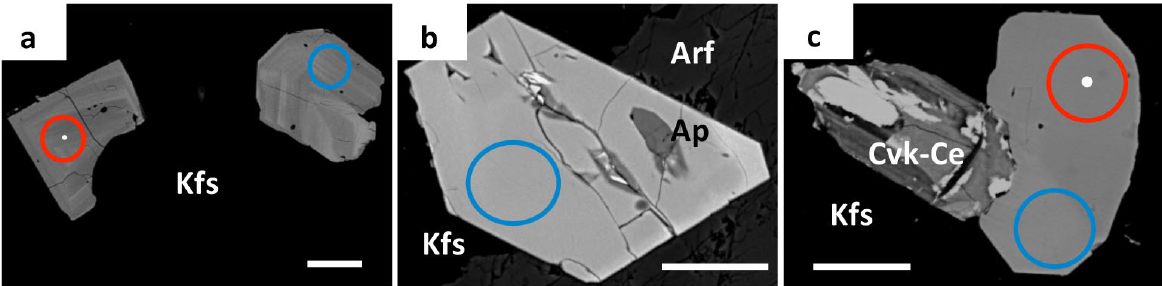
Figure 4. BSE images of magmatic zircon crystals in peralkaline granite from the Corupá Pluton. ( a ): Euhedral crystals showing oscillatory zoning patterns included in K-feldspar (Kfs); ( b ) euhedral crystal with slightly zoning and an apatite (Ap) inclusion between K-feldspar and arfvedsonite (Arf); ( c ) Euhedral crystal with slightly patchy zoning pattern associated with pristine (main brighter area) and hydrothermally altered (darker areas) chevkinite-(Ce) (Cvk-Ce). White dots, red circles, and blue circles indicate the locations of WDS, LA-ICPMS, and LA-MC-ICPMS spot analysis, respectively. The white bars measure 50 μ m.